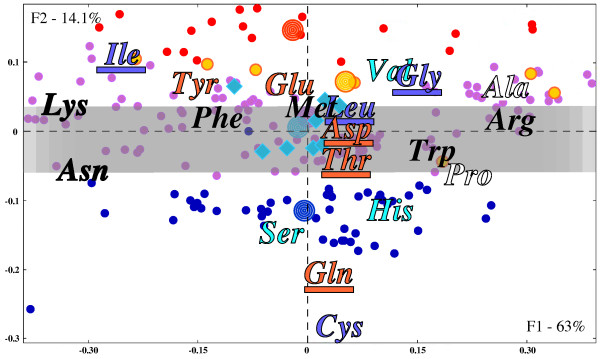
Species distribution and characteristic amino-acid compositional signatures. Factorial plane representation and species colour coding are as in Figure 1. Amino acids (three letters) are discriminated according to statistically significant mean compositional differences (at the probability level of p < 0.001, see text and Additional file 3) between the three segregated groups (hyperthermophiles-thermophiles, HTH-TH; prokaryotic mesophiles-psychrophiles, PMES-PSYC; eukaryotes, EUK): amino acids in pale blue (Val, His, Ser) are characteristic for each of the three groups; amino acids in orange (Tyr, Glu, Asp, Thr, Gln) are characteristic for HTH-TH; amino acids in dark blue (Gly, Ile, Leu, Cys) are characteristic for EUK; amino acids in black (Lys, Asn, Phe, Met, Trp, Arg) show no significant differences between the three groups (Ala and Pro show only partial significant differences: between EUK and PMES-PSYC); for a given class, underlined amino acids correspond to high values steadily decreasing in the three groups downward (HTH-TH to PMES-PSYC and to EUK) whereas non-underlined amino acids correspond to low values steadily increasing in the same direction.